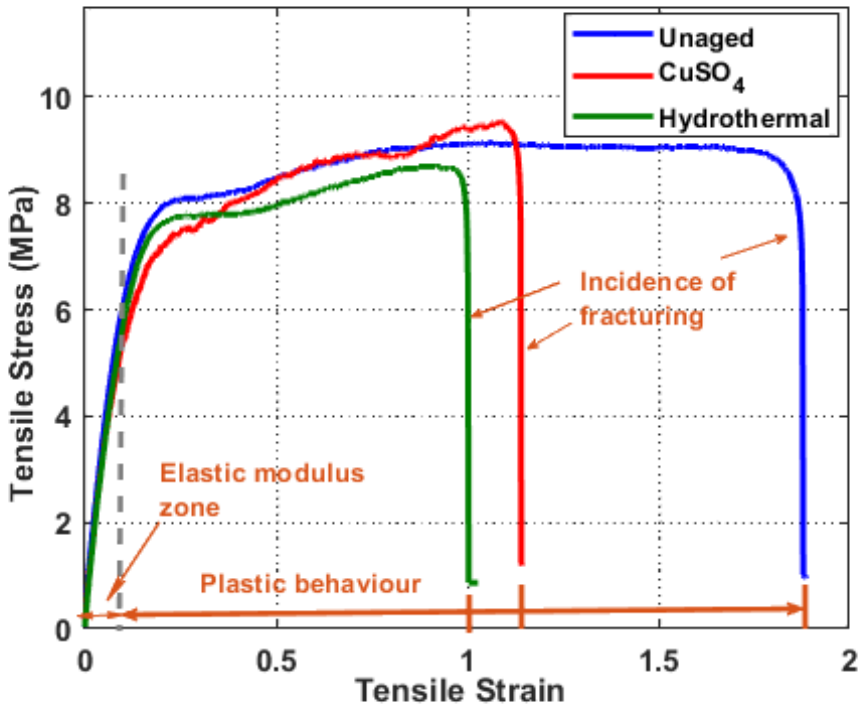
Figure 5. Tensile stress-strain curves for unaged and aged XLPE.